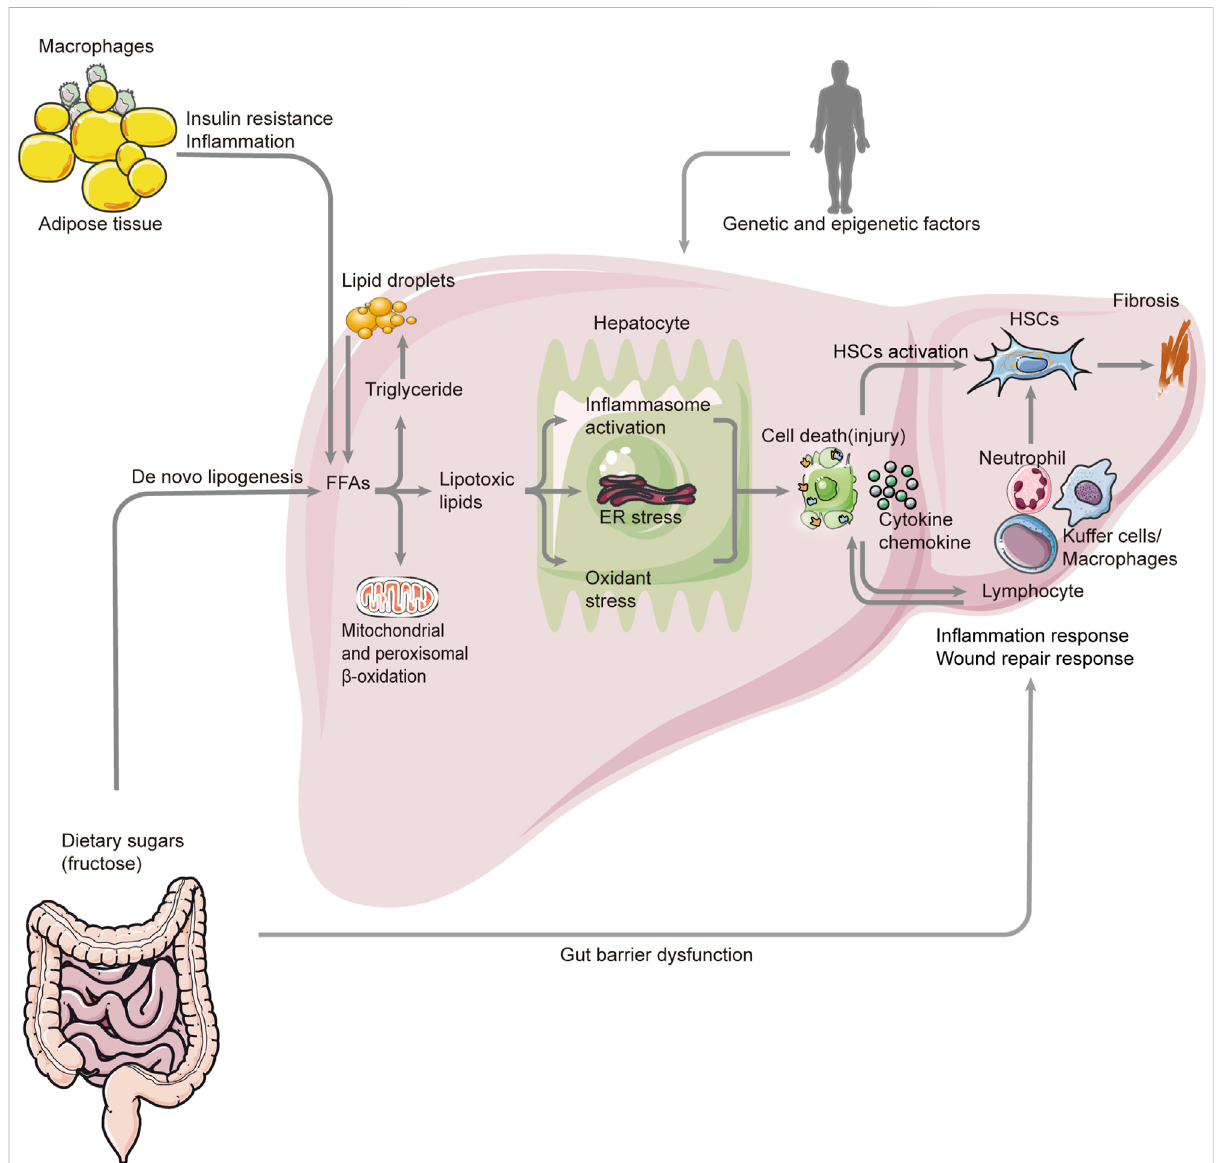
Overview pathogenesis of NASH. The pathogenesis of NASH involves many aspects such as genetic and epigenetic factors, metabolism, gut – liver axis, cell death (injury), in fl ammation, fi brosis, and so on. Also, the FAA is a key factor in this process. There are two major sources of FAAs. One is from the lipolysis of triglyceride in adipose tissue, and the other one is de novo lipogenesis. The excessive accumulation of FAAs and triglyceride leads to lipogenesis, which triggers in fl ammasome activation, ER stress, and oxidant stress. These result in the death (injury) of hepatocytes and the release of chemokines and cytokines. Also, they activate HSCs, which can cause fi brosis. At the same time, many immune cells respond to thisprocess, promoting in fl ammation and fi brosis. Inaddition, thealtered gut microbiome and permeability can also causein fl ammation response by activating the in fl ammatory cells. NASH: non-alcoholic steatohepatitis; FAA: free fatty acid; ER: endoplasmic reticulum; HSC: hepatic stellate